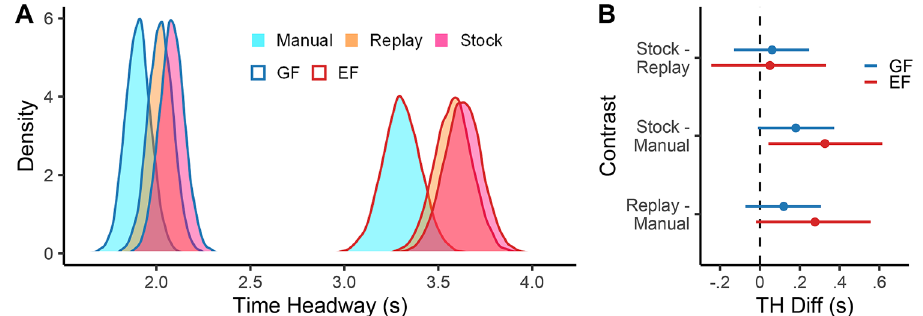
Figure 8. Posterior cluster means and contrasts. ( A ) Posterior distributions of condition means, for both GF and EF clusters. ( B ) Posterior estimates of the mean differences between each condition. Error bars are 95% highest density